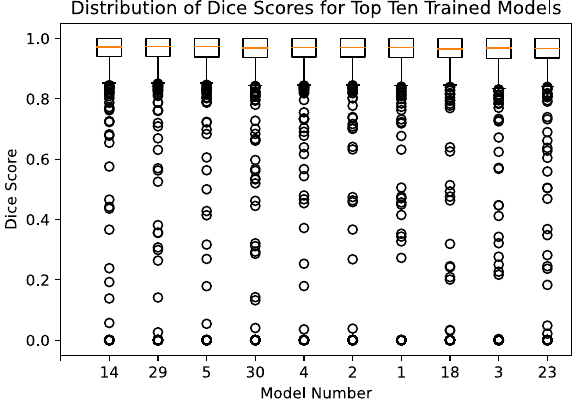
Figure 6. Box plot of the DSC score results for the top ten trained models on the patch testing set in the Hyper- Parameter tuning trial, where the models x-axis are in decreasing order of their mean Dice score. We can see that all models perform quite similarly, with many outliers. These outliers are caused by non-root objects which are present in the input patch.